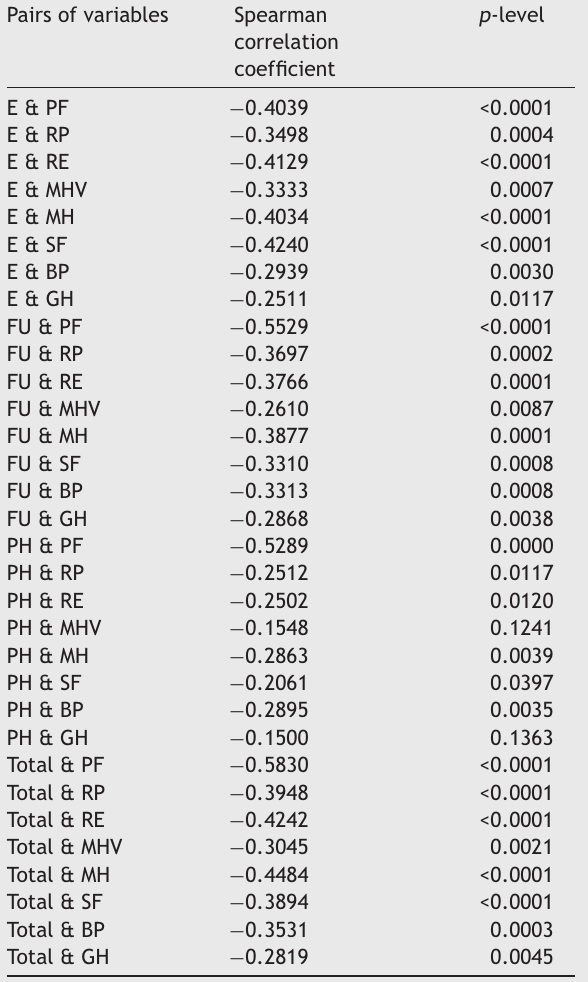
Correlations between DHI and SF-36 scores accord- ing to diagnosis ( n =